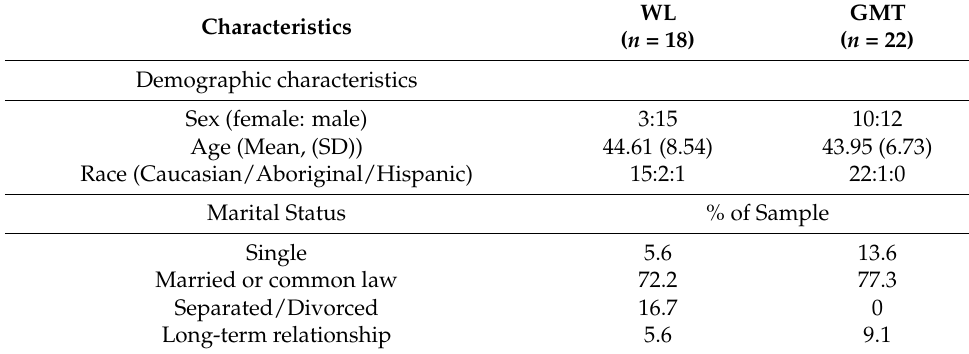
Table 1. Demographic and clinical characteristics of eligible